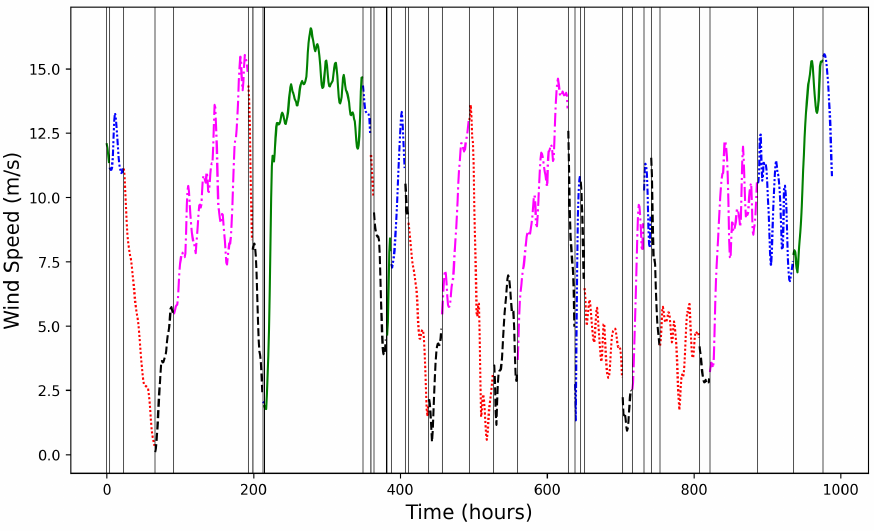
Figure 2. The dynamic time warping clustering.